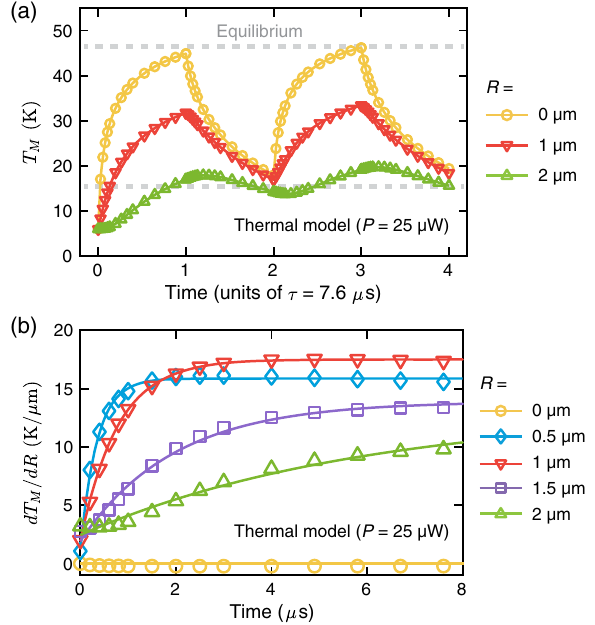
FIG. 9. Simulated thermal time dynamics. (a) Time-dependent heating and cooling of 1 L -MoS 2 during the first two excitation pulse cycles for τ ¼ 7 . 6 μ s and an excitation power of 25 μ W. The ending condition for panel (a) is used as the starting point of panel (b) (i.e., after two pulse cycles). (b) Simulated dependence of the thermal gradient dT M =dR versus the radial coordinate R for the third heating cycle, which ap- proaches the equilibrium distribution. The solid lines are fits C . The fitted rise times τ to A f 1 − exp ½ − ð t= τ for rise Þ(cid:4)g þ rise dT =dR ð R Þ are 0.35, 0.8, 2.0, and 6 . 0 μ s for R ¼ 0 . 5 , 1, 1.5, M and 2 μ m, respectively. The increasing rise time for the thermal gradient for larger j R j and its microsecond timescale are consistent with data for the stray magnetic field B due to max the photocurrents (Fig.